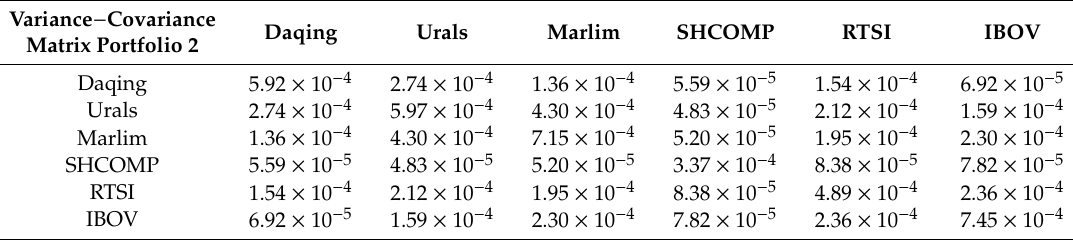
Table A26. Maximum Likelihood Variance–Covariance Matrices for portfolio 2: Daqing, Urals, Marlim, SHCOMP, RTSI, IBOV. Elaborated by authors with data from Bloomberg.